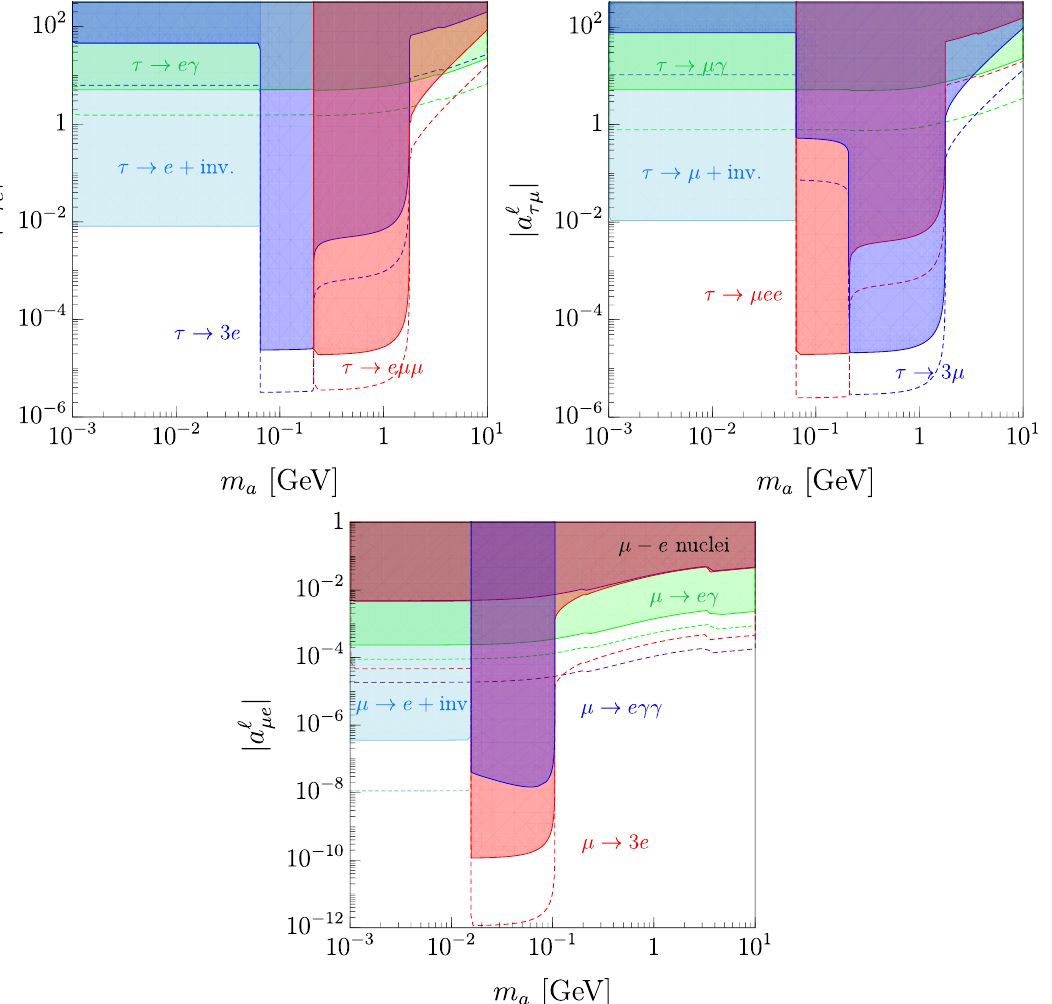
Figure 4 . Constraints on as a function of the ALP mass derived from the experimental bounds listed in table 1. Dashed lines correspond to future experimental prospects. We consider a benchmark scenario where a ‘ the only (cid:13)avor-conserving tree-level couplings, while c (cid:13)(cid:13) is induced at one-loop level, cf. eq. (3.36). The other couplings are neglected in our